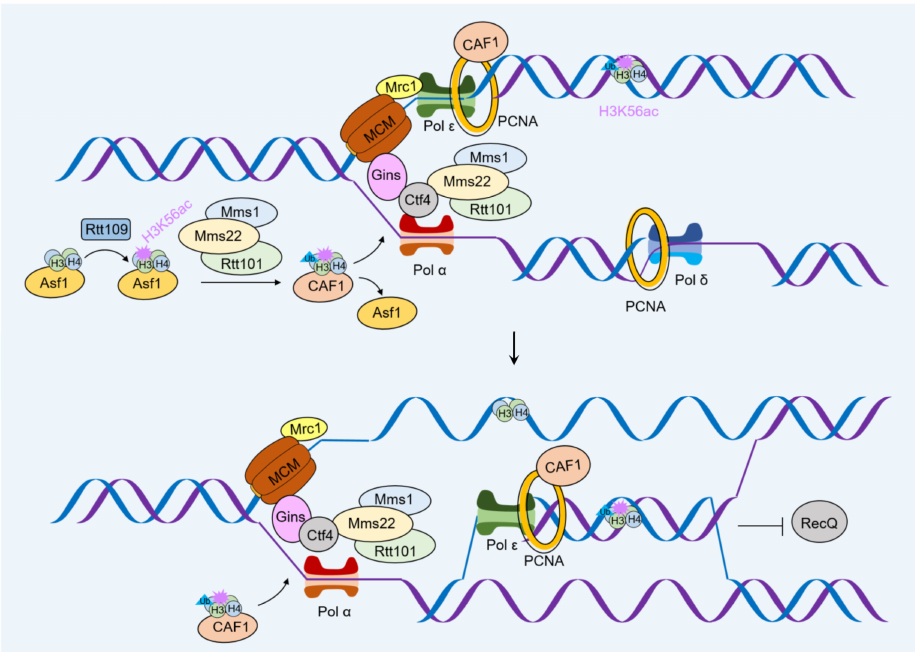
Figure 6. DNA damage tolerance by chromatin assembly in yeast. In yeast, replication-coupled, newly synthesized histones are deposited at the fork to mark chromatin with acetylated H3K56, which in turn activates ubiquitin ligase activity in the Rtt101 Mms1/Mms22 complex. Ubiquitination of Mrc1 and Ctf4 by unknown factors causes uncoupling of helicase CMG with polymerase and promotes recombination repair of bypass. In addition, the chromatin assembly factor CAF-1 interacts with the D-loop of the RecQ helicase by assembling the nucleosome onto the D-loop and abolishing the D-loop dissociation